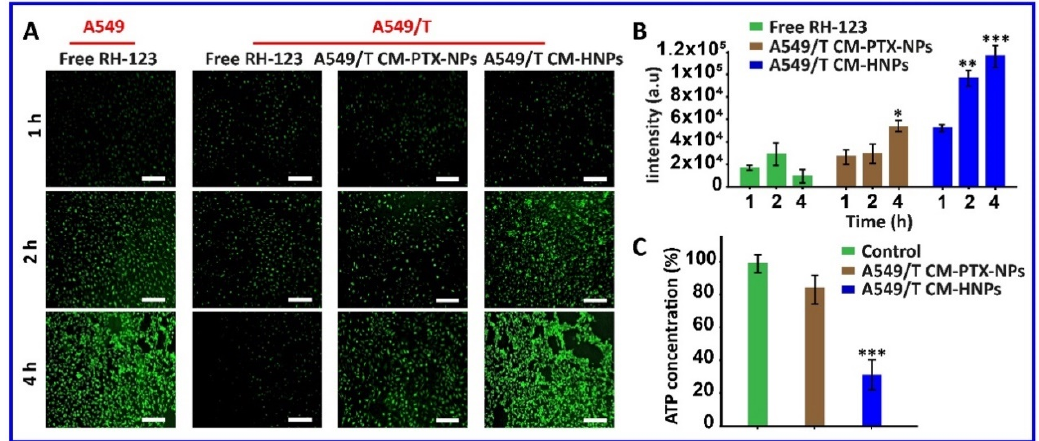
Figure 11. P-gp drug efflux inhibition. ( A ) Fluorescence images of A549 and A549/T cells after 1, 2, and 4 h incubation with the free Rhodamine 123 (RH-123) (5 mM) in the absence and presence of A549/T CM-HNPs and A549/T CM-PTX-NPs at a fixed PTX concentration of 5 μ g/mL at 37 °C, scale bar: 100 μ m. ( B ) Fluorescence intensity of A549/T cells after 1, 2, and 4 h incubation with the free RH-123 (5 mM) in the absence and presence of A549/T CM-HNPs and A549/T CM-PTX-NPs at a fixed PTX concentration of 5 µ g / mL at 37 ◦ C. ( C ) Intracellular ATP concentration in A549 / T cells at 4 h post-treatment. * p <